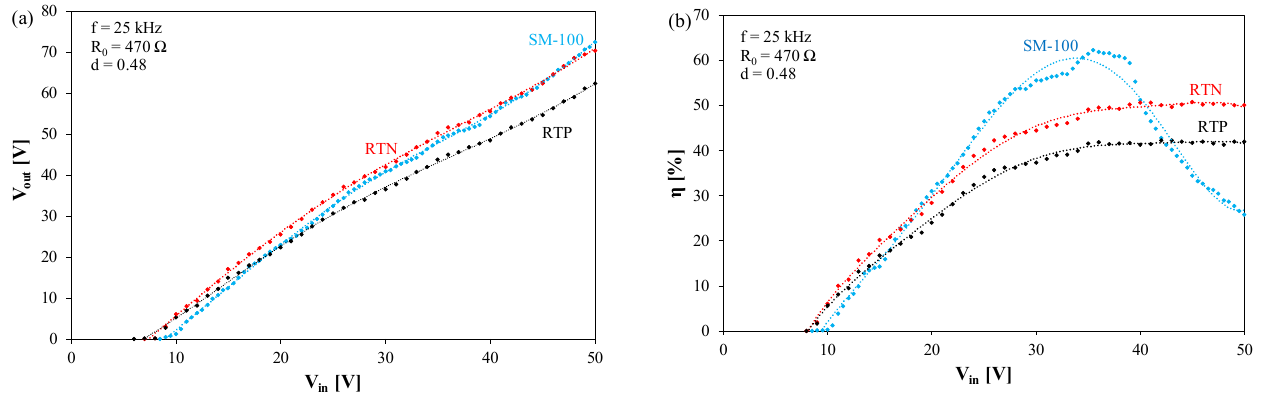
Figure 6. Measured dependences of the output voltage ( a ) and energy efficiency ( b ) of the tested DC-DC converter on its input voltage at R 0 = 470 Ω and d = 0.48.